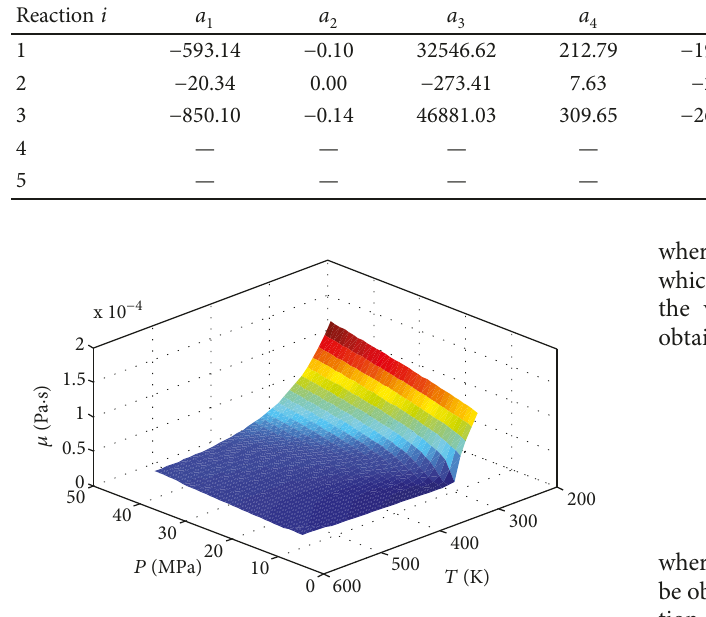
Figure 1: Variation of viscosity with temperature and